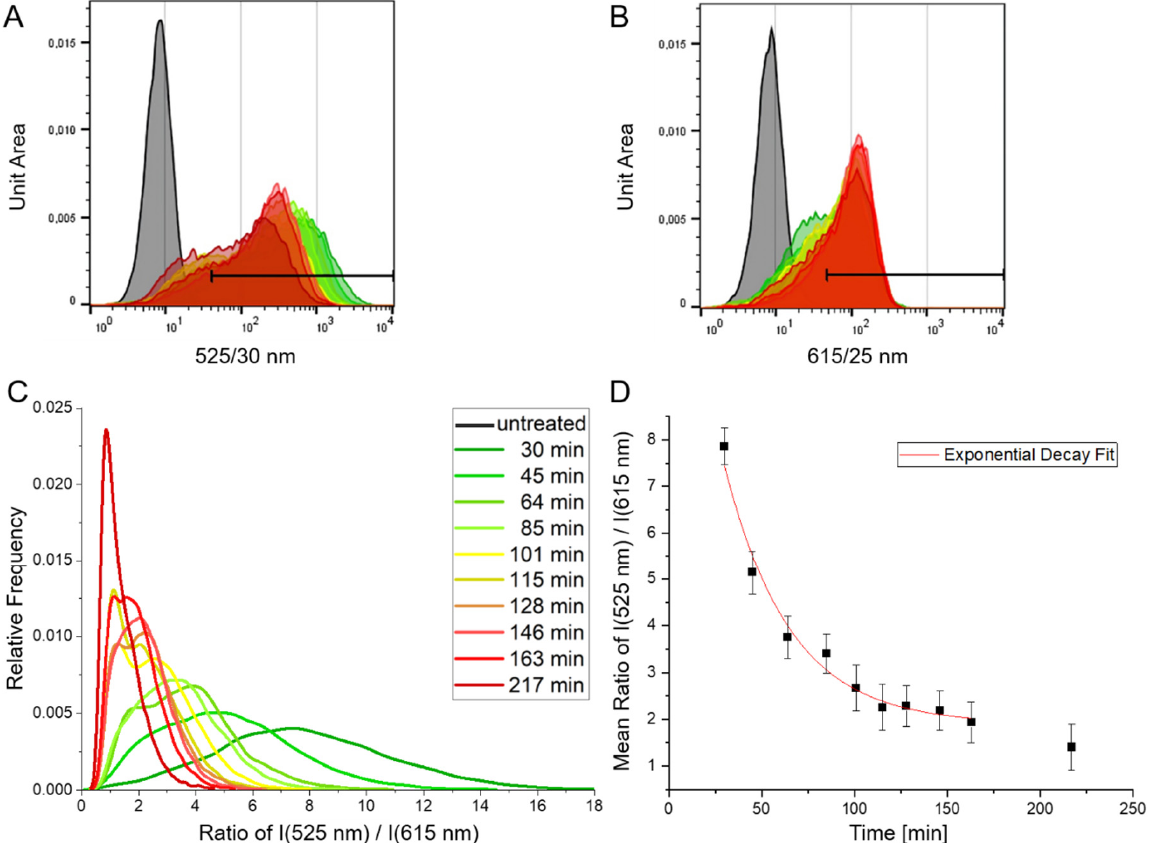
Figure 5. A431 cells expressing a high level of EGFR were incubated with EGF-CoGFP-mCRISPRed at 37 °C, and fluorescence emission was measured at the indicated timepoints using flow cytometry. Histograms show fluorescence emission at ( A ) 525/30 nm ( B ) 615/25 nm for each timepoint upon 488 nm excitation. Bar gates indicate cells with a fluorescence above that of 99% of untreated reference cells. Each measured population comprises 13,000–17,000 events. ( C ) The ratio of emission intensities at 525 nm to 615 nm was calculated for each cell. ( D ) Mean values of ratios for each population were plotted against the time. Error bars represent the relative standard error. Data points from 30–163 min were fitted with an exponential decay function y ( x ) = 13.07 exp( − x /34.97) +1.90 ( R 2 = 0.97) resulting in a rate of k = (0.029 ± 0.004) min − 1 .